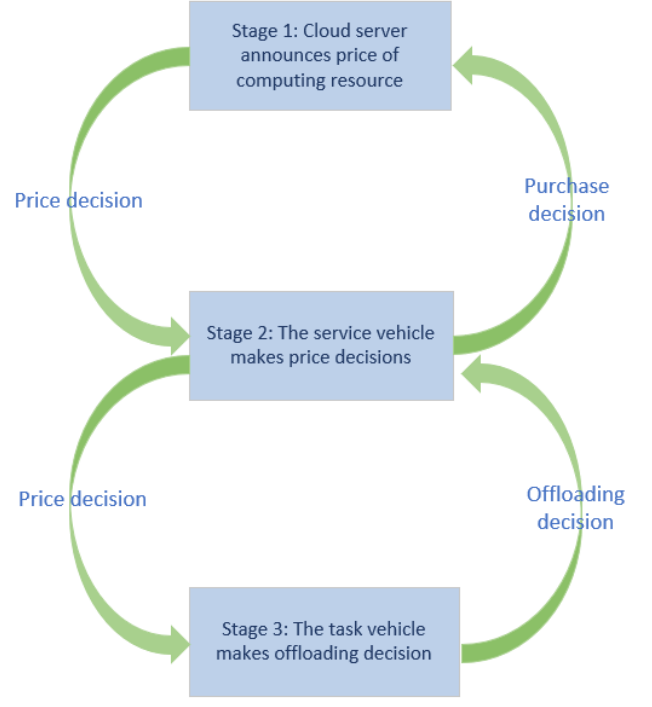
Figure 2. Three-stage Stackelberg game